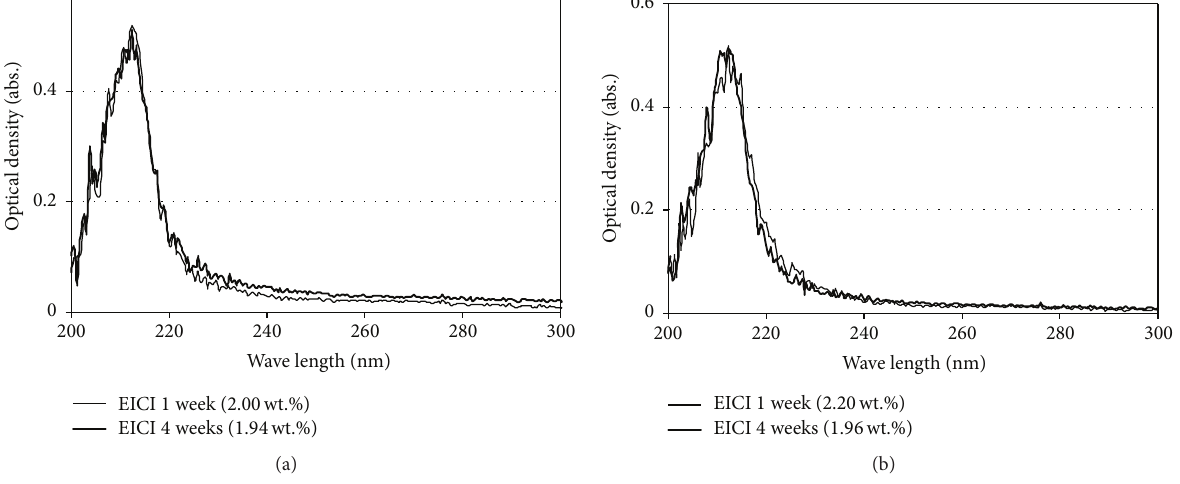
Figure 6: UV-Vis spectra of cement mortar samples after EICI treatment in sodium borate solution: (a) uncontaminated sample; (b) contaminated